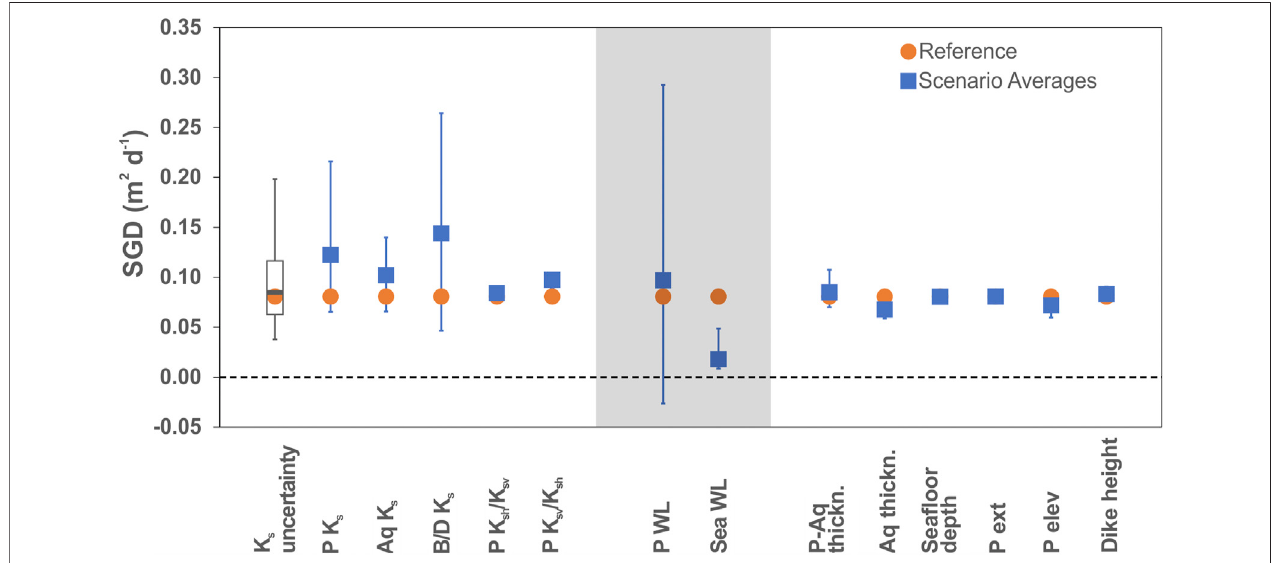
FIGURE 5 | Range of submarine groundwater discharge in different scenarios with results of K s uncertainty analysis (boxplot). Blue boxes are averages of the scenariosimulationsandtheerrorbarsrepresenttherange.Errorbarsofuncertaintyanalysisrepresenttheupperandlowerboundsbasedon ± 1.5*InterquartileRange. The reference scenario fl ux is represented here in orange dots. The shaded area separates the three groups of properties. Notations: P, peat; Aq, aquifer; B/D, beach/ dune; WL, water level; ext, extension.